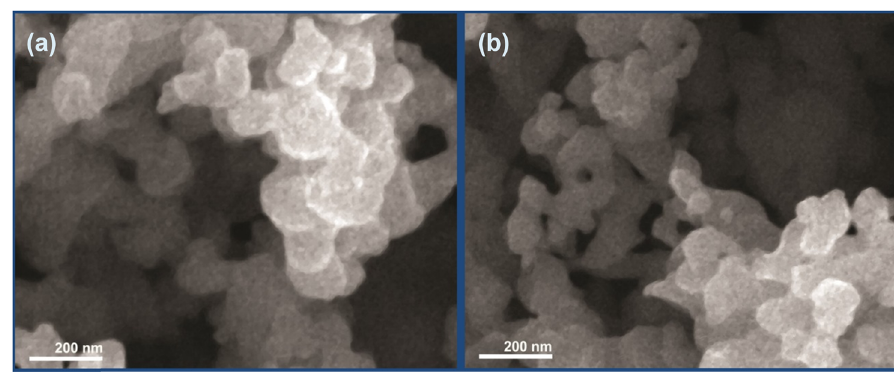
Figure 2: Scanning microscopy images of EOs loaded NCs: ( a ) thyme oil - CS/ALG NC and ( b ) garlic oil - CS/ALG NC.